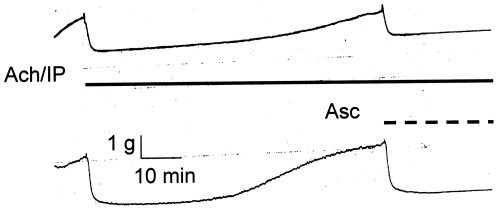
Ascorbate (500 µM) reversal of the fade of 30 nM isoproterenol relaxations of 1 µM Ach contractions of twp separate guinea pig tracheal rings.The solid horizontal line indicates duration of Ach/IP application. The dashed line indicates the application of Asc.